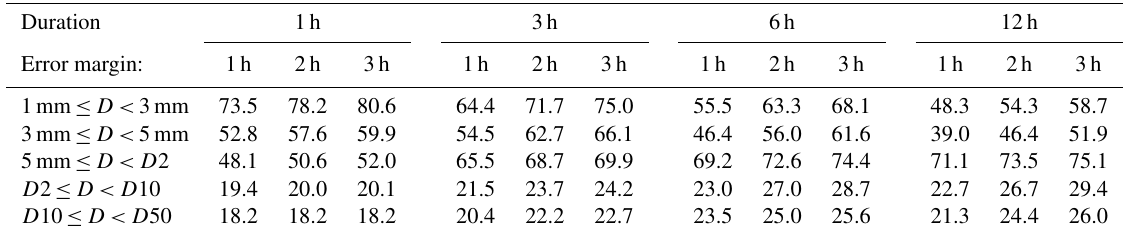
Table 2. Fraction (%) of time steps where the D -category of the automatic station agrees with the one of HIPRAD3 when allowing an error margin of 1, 2 and 3h, for durations 1, 3, 6 and 12h. Duration 1h 3h 6h 12h Error margin: 1h 2h 3h 1h 2h 3h 1h 2h 3h 1h 2h 3h 1mm ≤ D < 3mm 73.5 3mm ≤ D < 5mm 52.8 57.6 59.9 5mm ≤ D <D 2 48.1 D 2 ≤ D <D 10 19.4